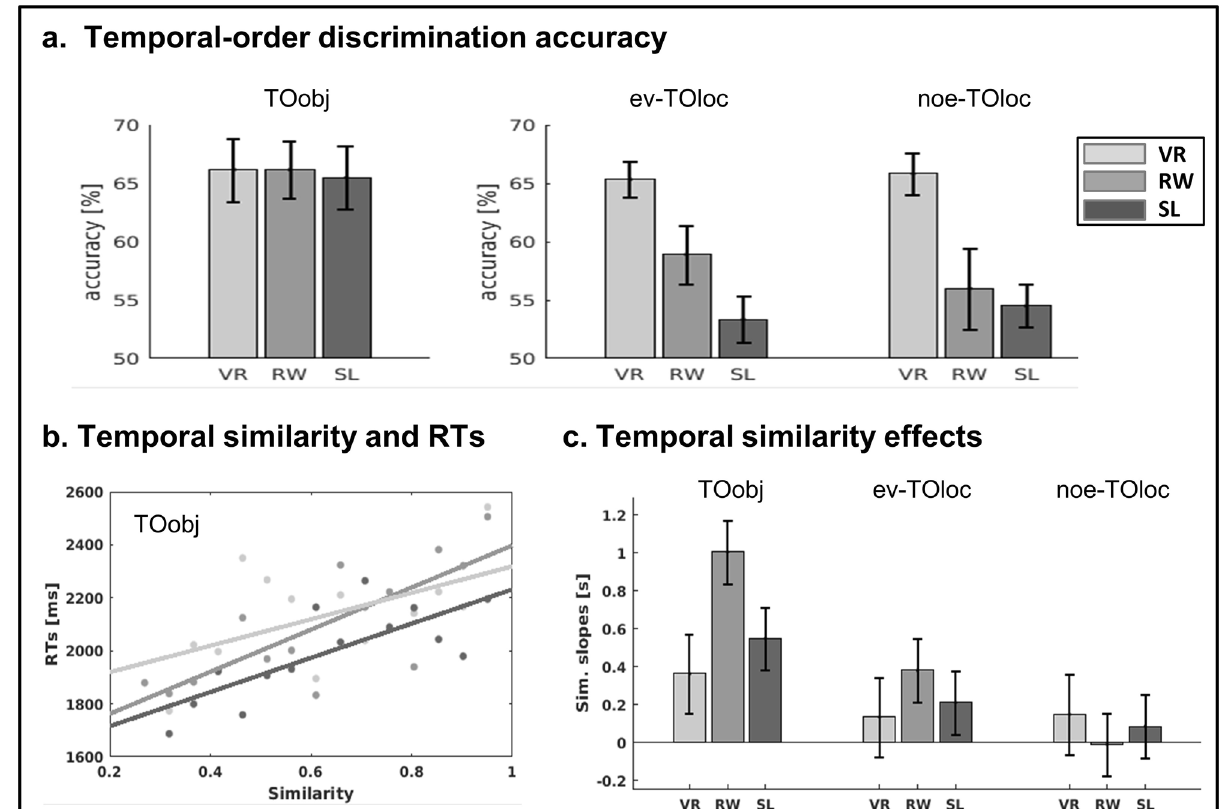
Figure 4. Results of temporal-order judgment task. ( a ) Mean accuracy (%, ± SEM) of the temporal-order discrimination task using object-images as retrieval cues ( TOobj ). ( b ) Mean accuracy (%, ± SEM) of the temporal-order discrimination task using place-images as retrieval cues (TOloc). The first 3 bars show the accuracy for places where an object-event took place ( ev-TOloc ), while the 3 bars on the right show the accuracy for trials comprising place-images without any object-event ( noe-TOloc ). ( c ) For illustration purposes only, the TOobj trial-specific data were averaged in 15 bins, allowing us to display the regression lines for the three protocols (VR, RW, SL). The regression lines show that the RTs increased with increasing temporal similarity, in all 3 experiments. ( d ) Average slopes (± SEM) of the regressions between temporal similarity and RTs, now calculated at the level of the individual participant and displayed separately for the different types of retrieval cues ( TOobj, ev-TOloc, noe-TOloc ) and the three encoding protocols (VR, RW, SL). The data analysis revealed a general effect of temporal similarity across experiments, supporting scale invariance of order retrieval, but also a significant effect of cue-type indicating that factors other than chronological distance also contributed to temporal order retrieval, see “Discussion”